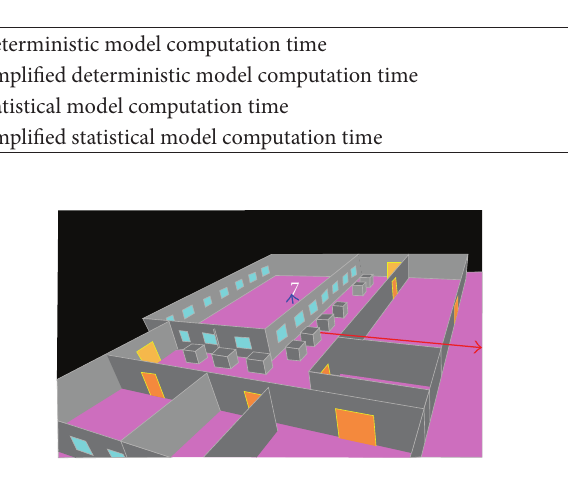
Figure 9: 3D view of the simulation environment of the downlink